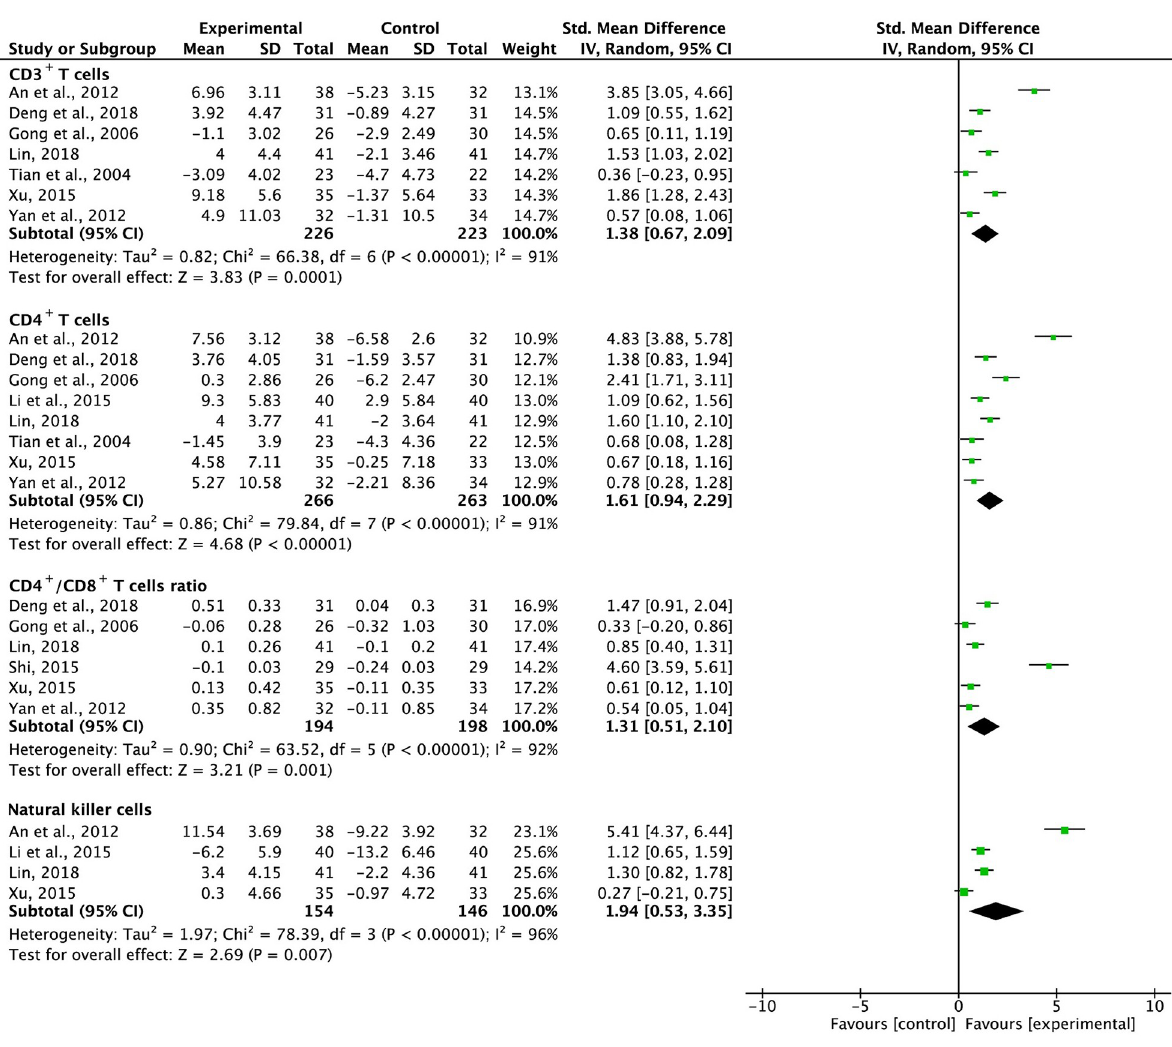
Fig 7. Meta-analysis results of the proportion of peripheral blood